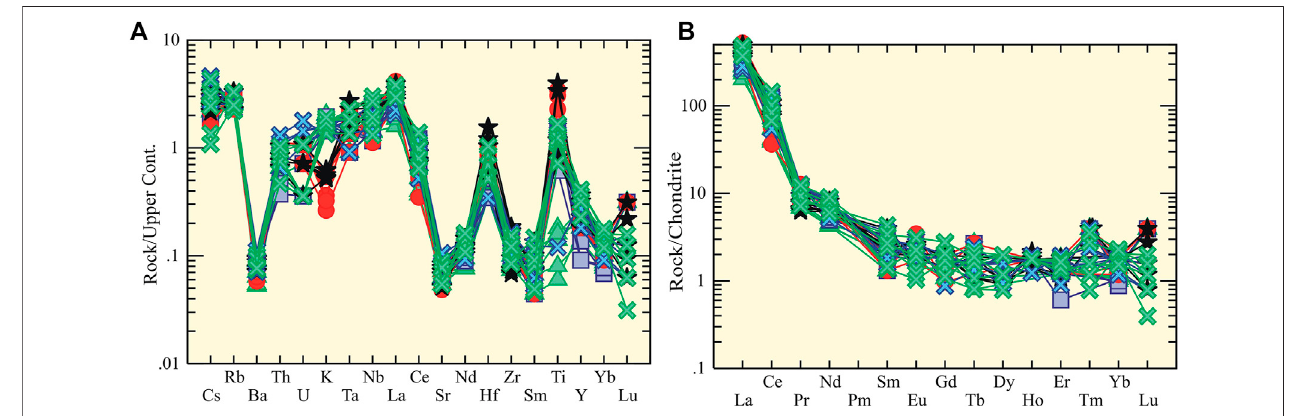
FIGURE10|(A) TraceelementsofthestudiedpegmatitesnormalizedtotheuppercontinentalcrustofTaylorandMcLennan(1985);and (B) chondrite-normalized REEs of Sun and McDonough (1989).